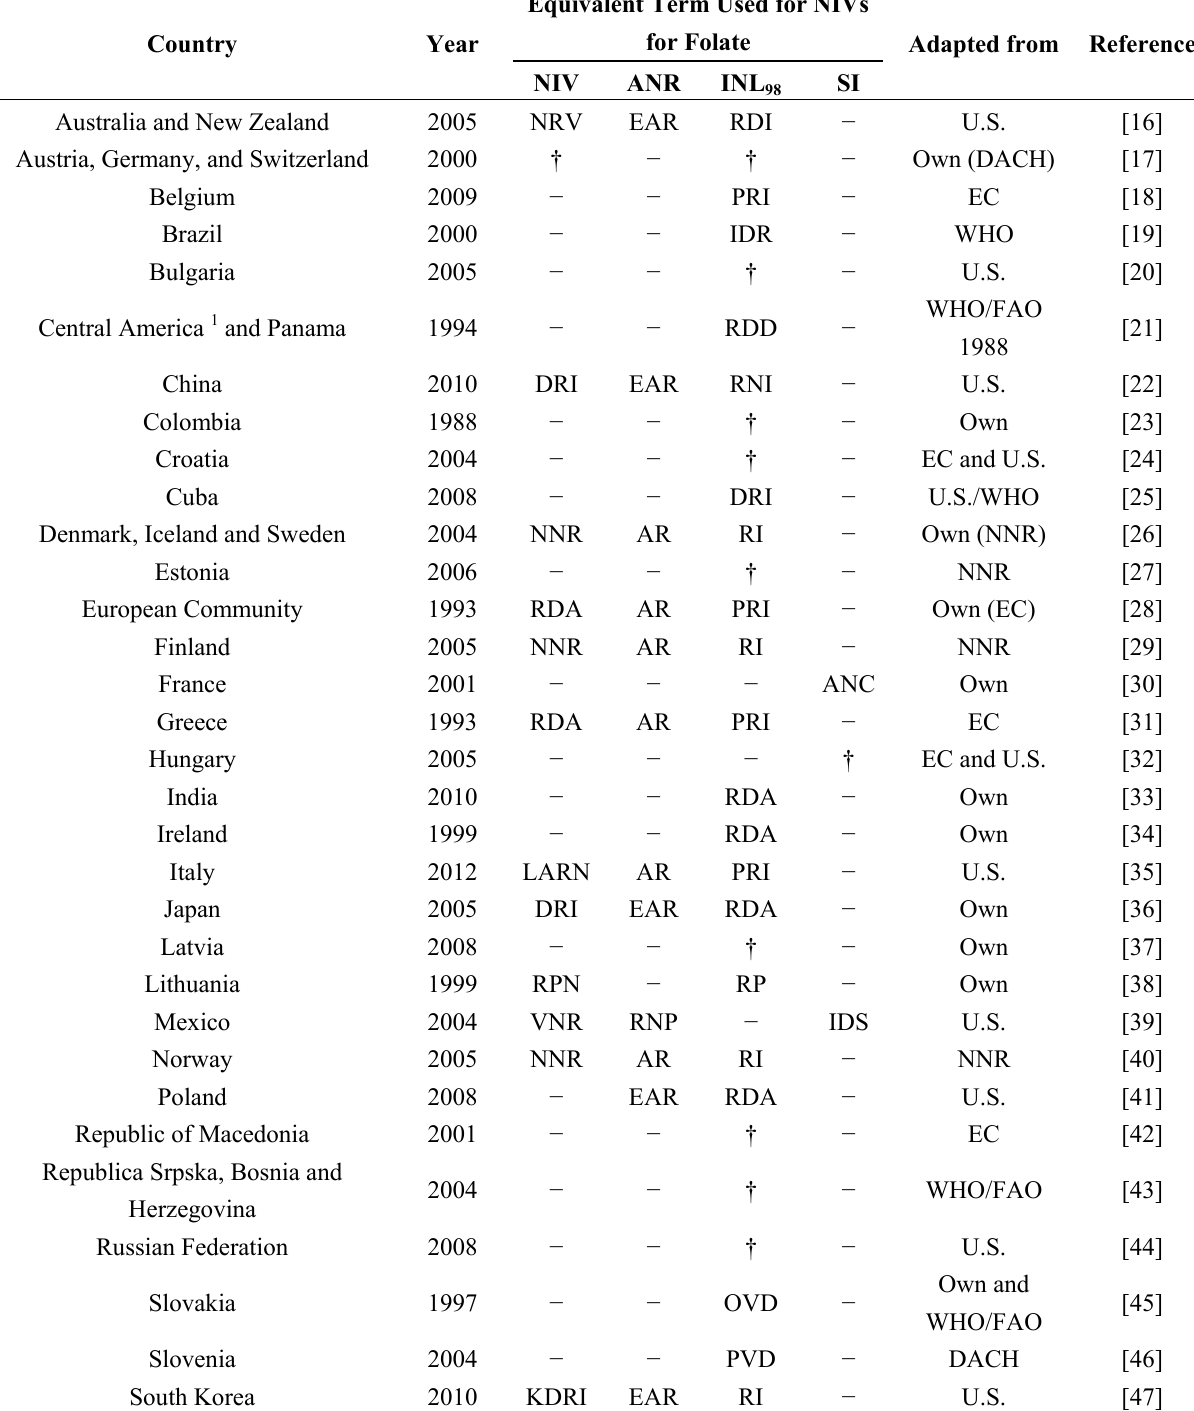
Table 1. Sources of country Nutrient Intake Values and country specific terminology used for folate Nutrient Intake